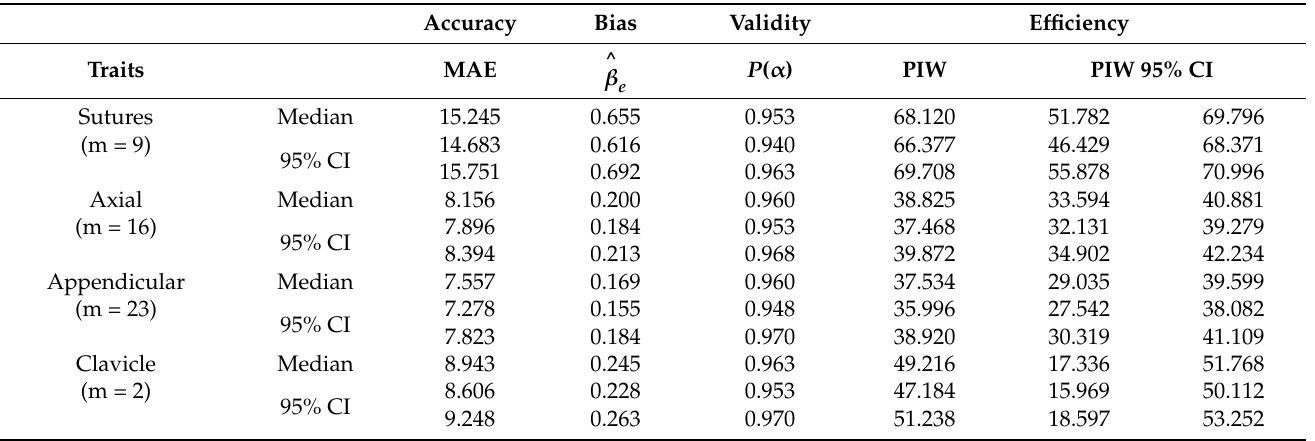
Table 3. Leave-one-out cross-validation metrics for DRNN models built on pre-specified skeletal traits